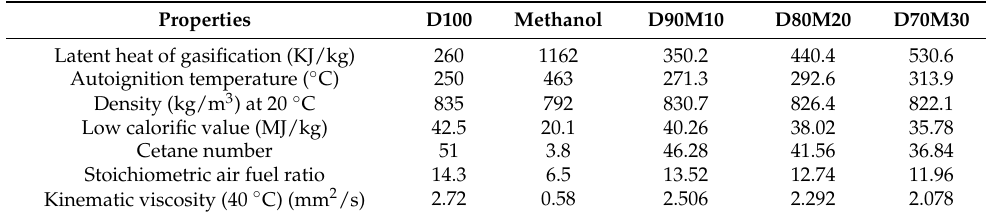
Table 2. Main physical and chemical properties of the fuel.